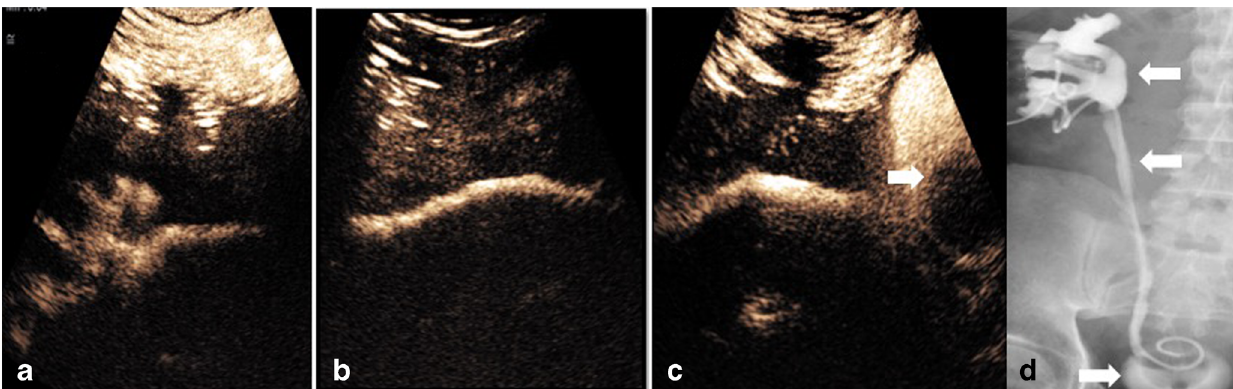
Fig. 7 CEUS nephrostogram. Images obtained of the entire ureter and bladder following ultrasound contrast administered through an in- dwelling nephrostomy confirms patency of the collecting system with contrast opacifying the (A) renal calyces, (B) ureter and (C) bladder,